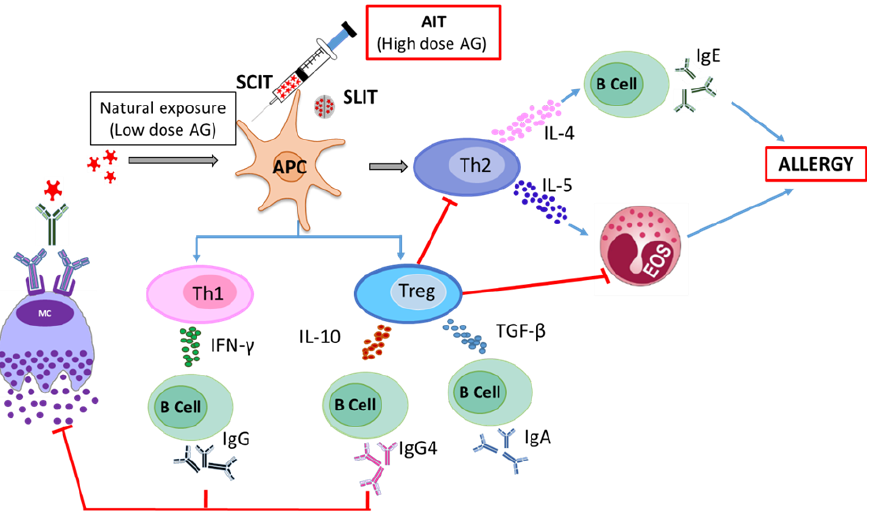
Figure 1. Mechanisms of allergy induction and allergen-specific immunotherapy.